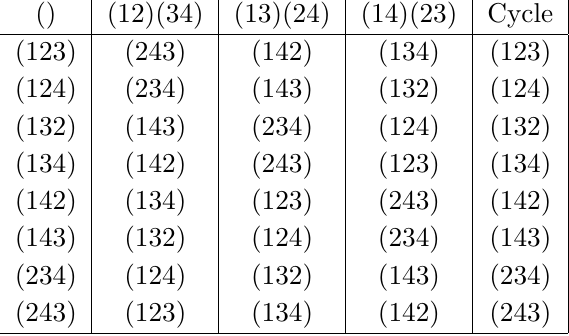
Table 9 . Right multiplication of fV